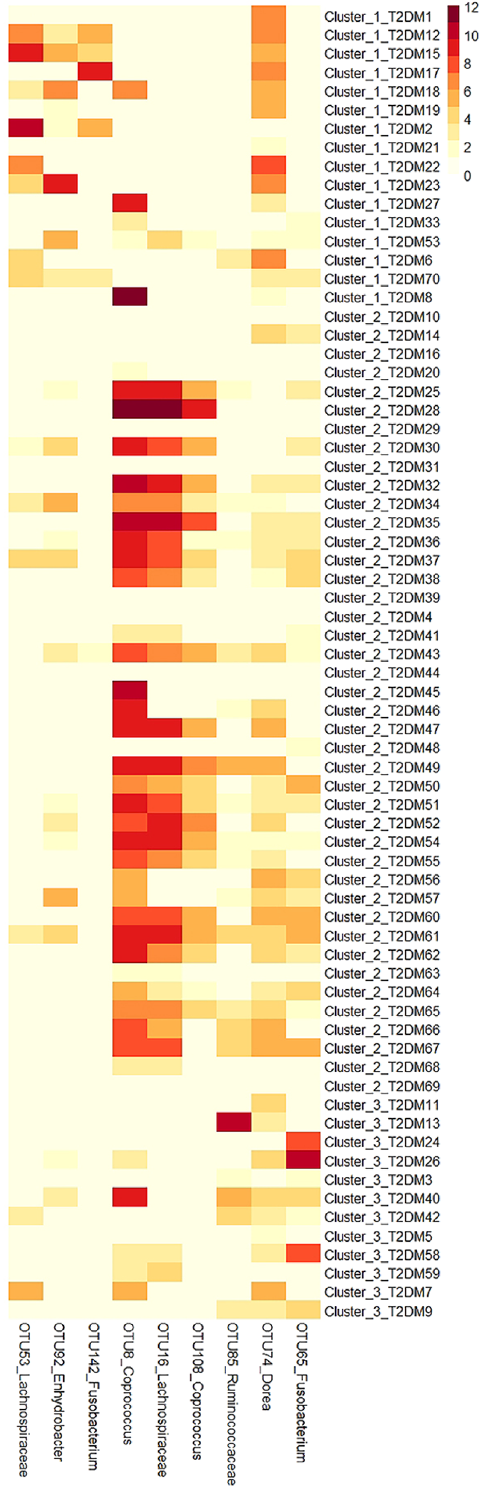
Figure 3. Distribution of T2DM associated OTUs in the three clustered T2DM patients visualized in a heatmap. Note: the abundance of the OTUs were transformed in log 2 (raw read + 1) in the heatmap, and the heatmap figure was done in R version